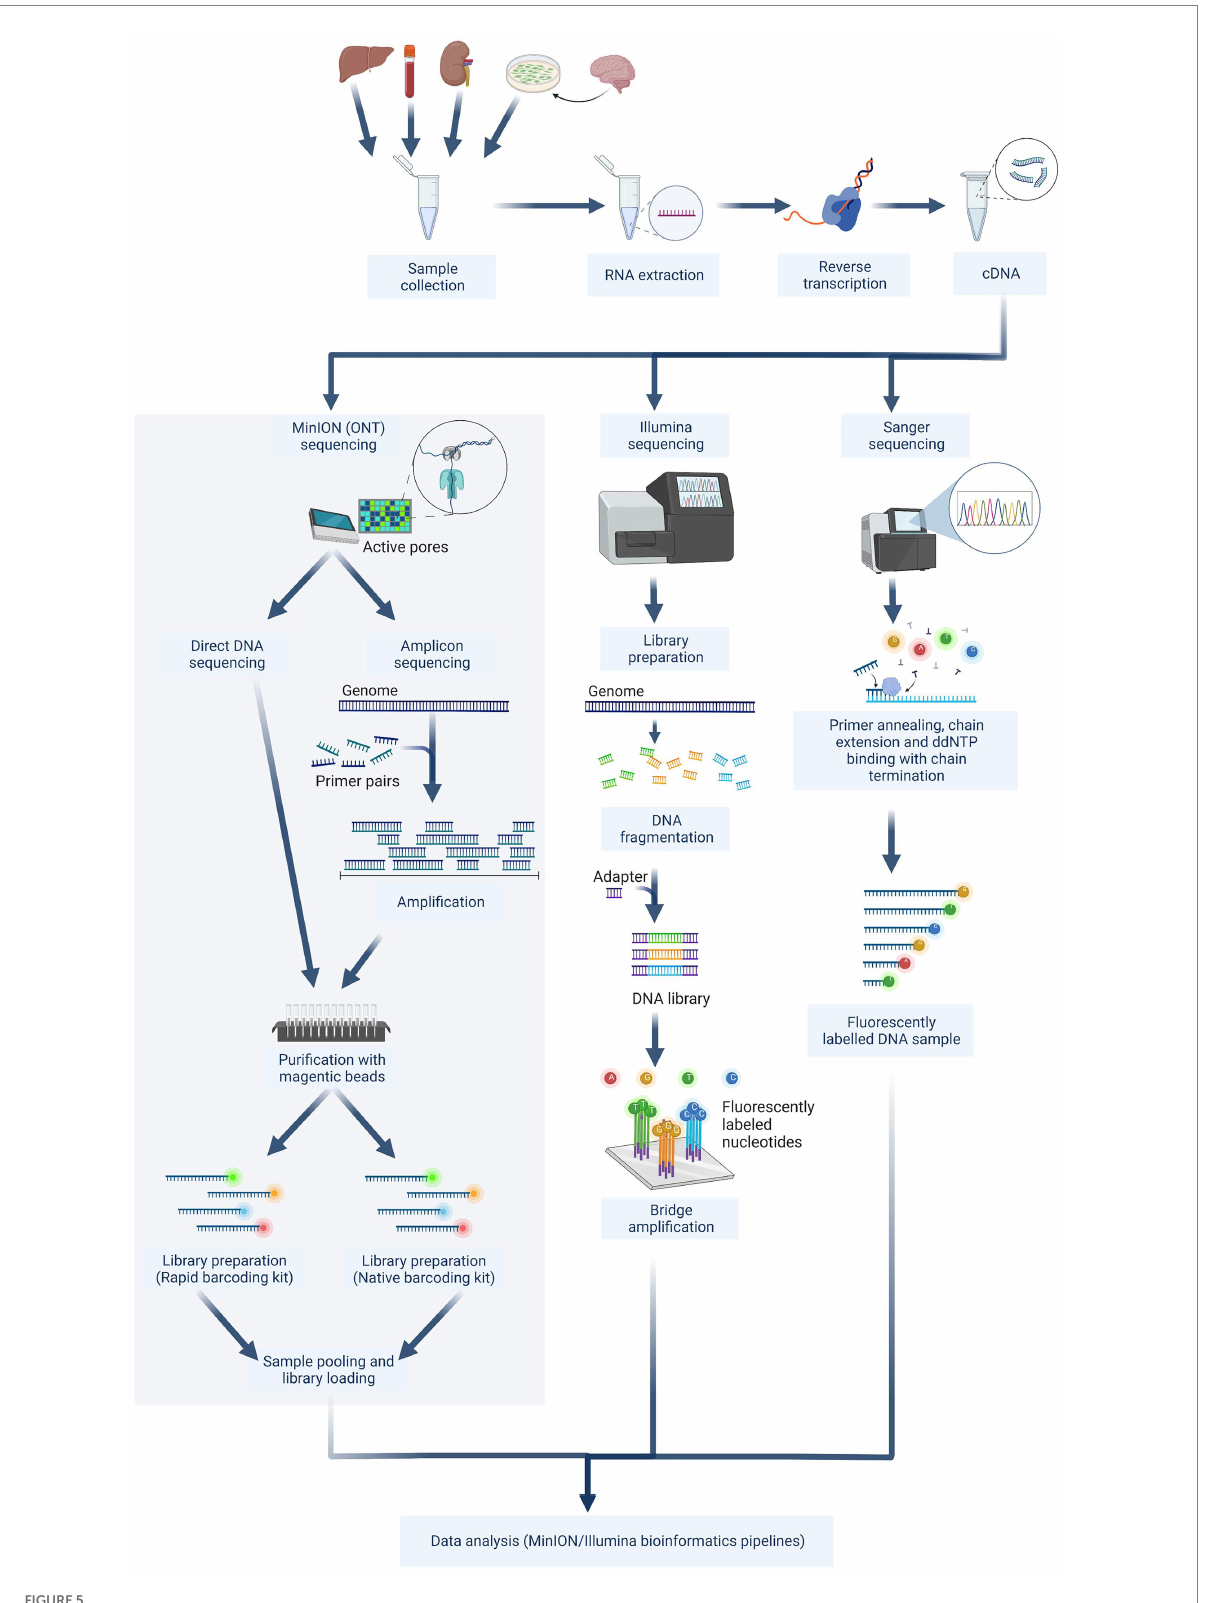
FIGURE 5 The next-generation sequencing workflow contains three sequencing approaches. The schematic figure was drawn with Biorender.com. ddNTP, Dideoxyadenosine